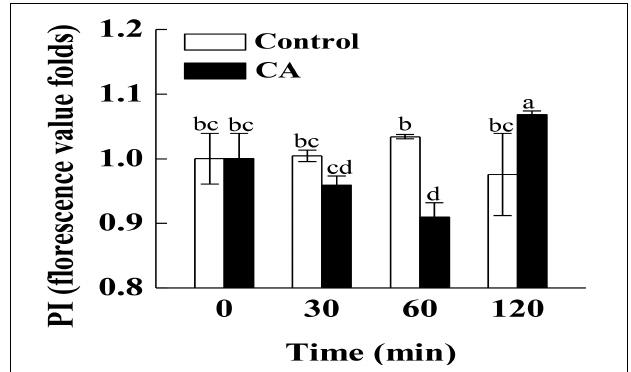
FIGURE 2 | Effects of CA on the plasma membrane integrity of G. citri-aurantii mycelia. The data presented are the means of pooled data. Error bars indicate the SDs of the means ( n = 3). Bars with different lower-case letters between different groups indicate significant differences according to duncan’s test ( P < 0.05).